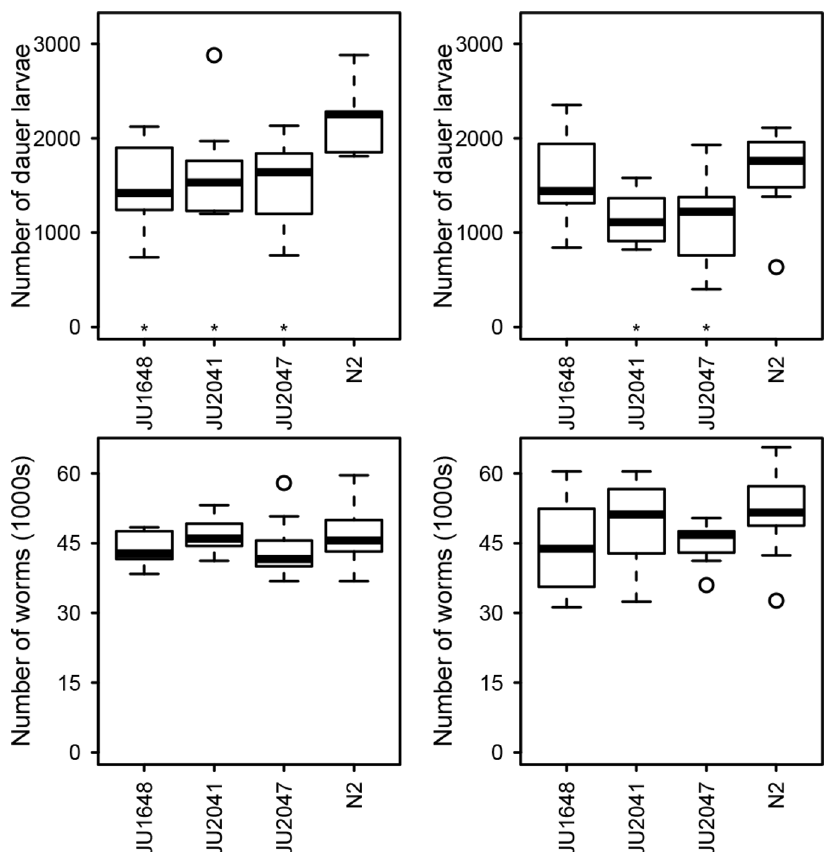
Figure 3. Variation surrounding nath-10 affects the number of dauer larvae at food exhaustion in growing populations. Box and whisker plots showing number of dauer larvae (top panels) and the population size (bottom panels) at exhaustion of 100 m l of 20% w/v food in two assays (left and right columns) in N2 and in JU1648, JU2041 and JU2047, lines with very fine introgressions of the nath-10(haw6805) allele in an N2 genetic background. The nath-10(haw6805 ) allele is the only common difference that distinguishes JU2041, JU2047, and JU1648 from N2, and JU2041 contains only two known alleles that differ from N2, nath-10(haw6805) and mfP19 (see [19] for further details). Asterisks indicate significant difference to N2 within that assay ( p , 0.05, post hoc testing by Fisher’s Least Significant Difference).